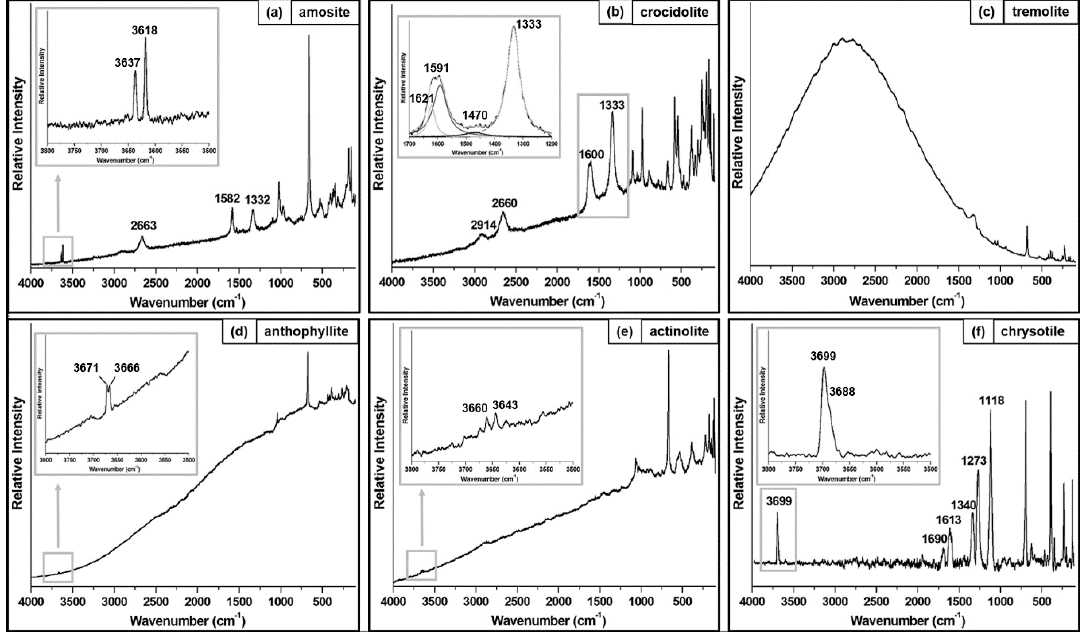
Figure 4. Raman spectra of the 4000–100 cm − 1 range obtained on the six regulated asbestos minerals: ( a ) amosite; ( b ) crocidolite; ( c ) tremolite; ( d ) anthophyllite; ( e ) actinolite; ( f ) chrysotile.